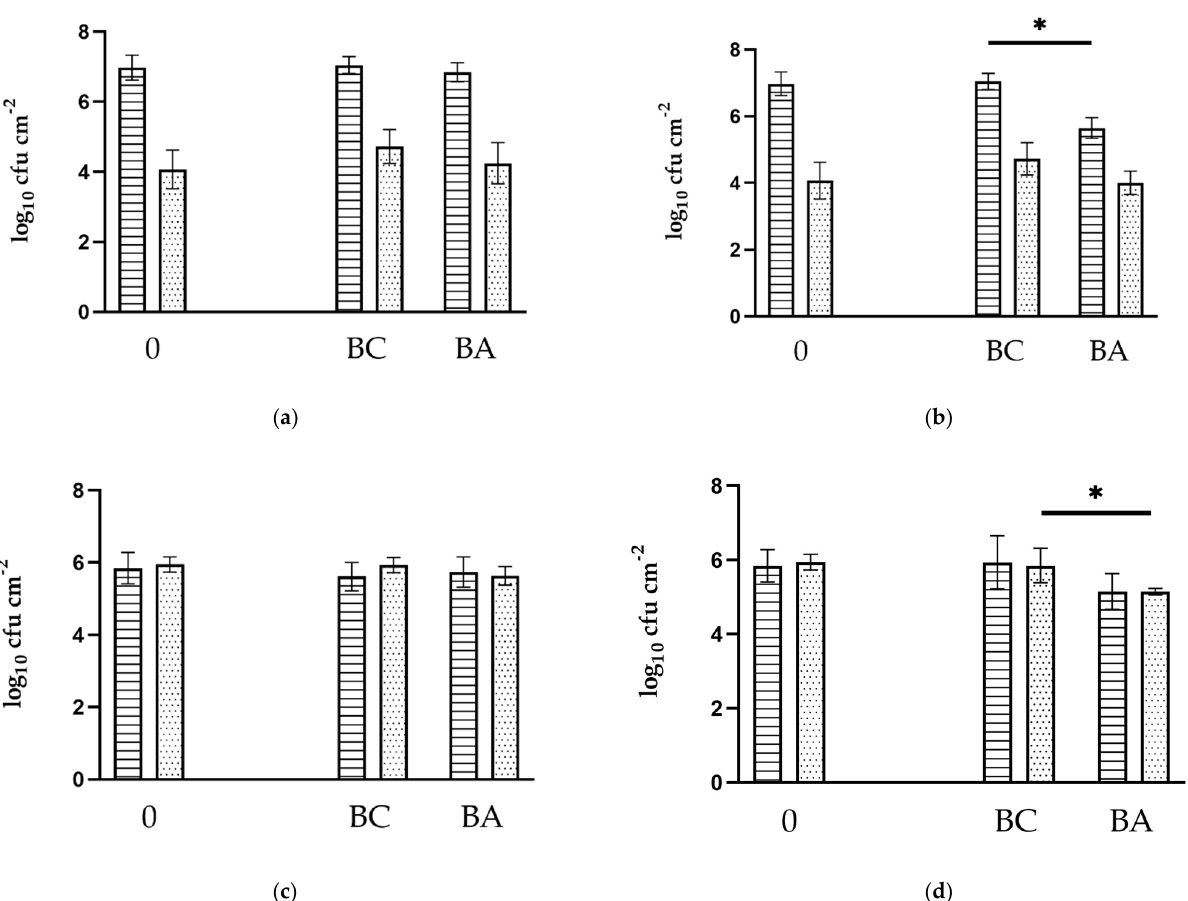
Figure 1. Population distribution (log 10 cfu cm − 2 ; means ± SD) of 7-day-old biofilms before (0) and after antibiotic application (BA) compared with controls stored the same period (BC). ( a , b ) Data for biofilms with P. aeruginosa; ( c , d ) Data for biofilms with P. fluorescens. ( a , c ) Results of exposure to SDZ/TMP (initial application: 150/30 mg L − 1 ); ( b , d ) Results of exposure to TYL A (initial application: 500 mg L − 1 ). Bars with striped and dotted patterns indicate log 10 -values for pseudomonads and E. coli , respectively. * Counts significantly different between exposed and control biofilms according to the t -test ( b ) P. aeruginosa p = 0.004; ( d ) E. coli p = 0.02, and Mann–Whitney test ( d ) E. coli p = 0.03.